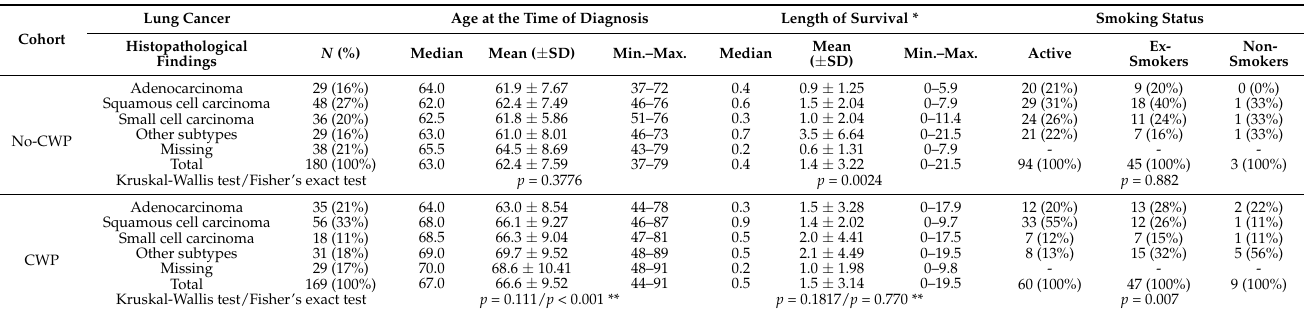
Table 3. Age at the time of the diagnosis, length of survival and distribution of smoking status classified by histopathological findings of